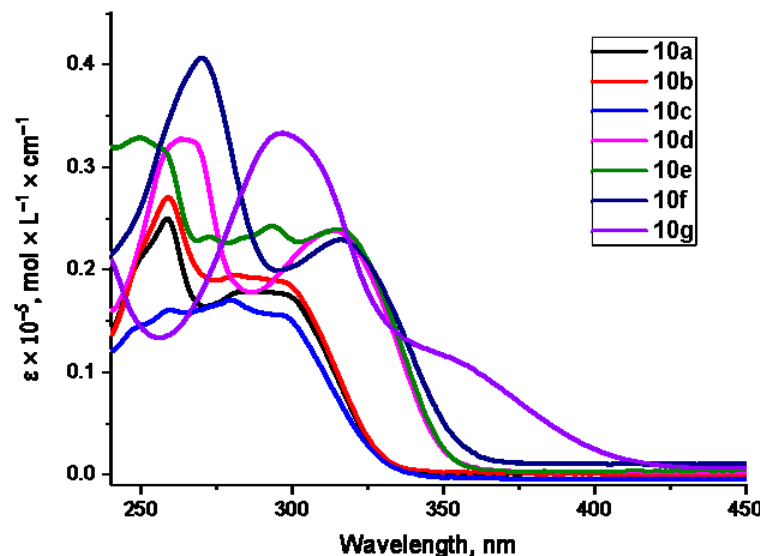
Figure 2. Absorption spectra of 10a – g in THF, C = 1 × 10 –5 M.